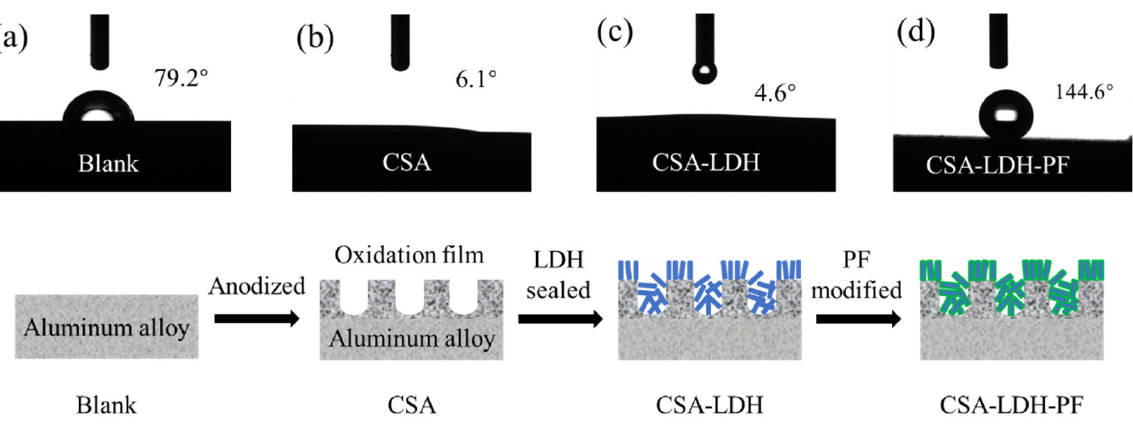
Figure 10. Contact angles of the ( a ) Blank, ( b ) CSA, and ( c ) CSA-LDH and ( d ) CSA-LDH-PF samples.